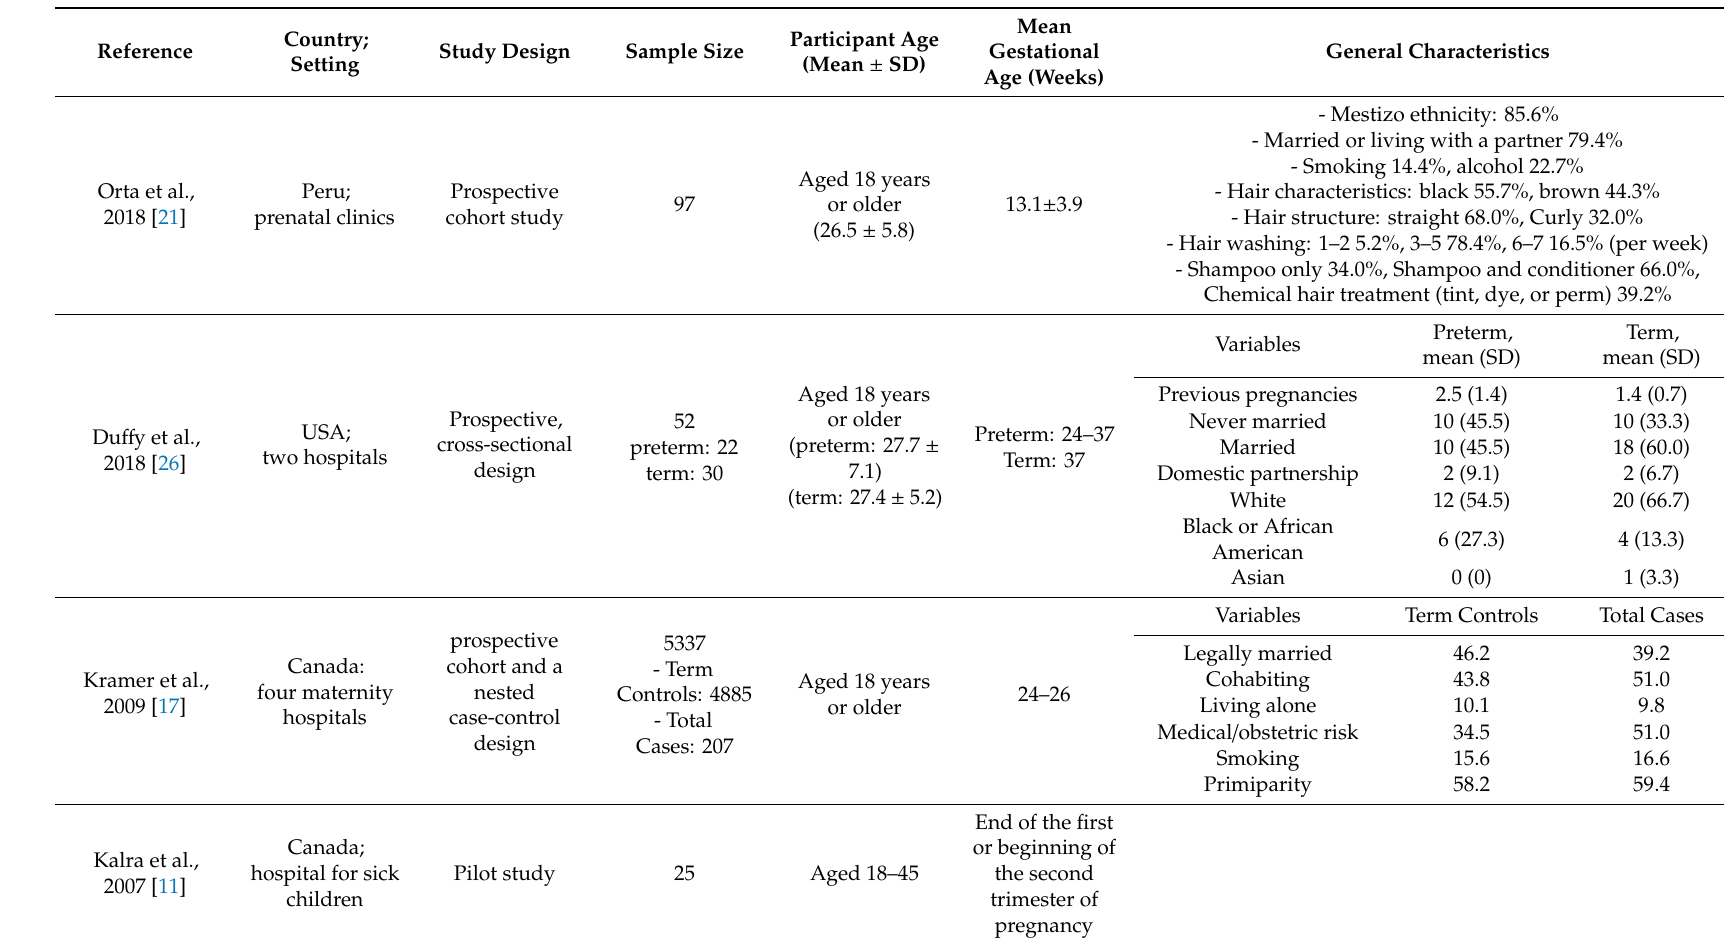
Table 1. Detailed description of reviewed